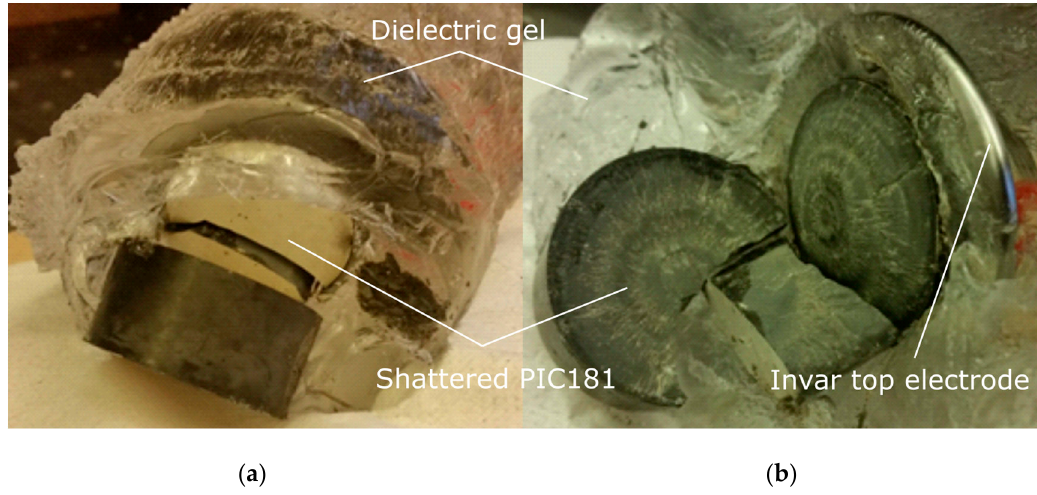
Figure 2. Failure of the first prototype MV photonic voltage transducer (PVT) after a series of lightning impulses that caused excessive accelerations, resulting in internal forces that exceeded the material’s mechanical strength. The picture illustrates the shattered piezoelectric transducer, taken out from the disassembled sensor unit, still partially covered with dielectric gel. The piezoelectric stack broken apart ( a ) and shattered piezoelectric component with a visible crater ( b ).